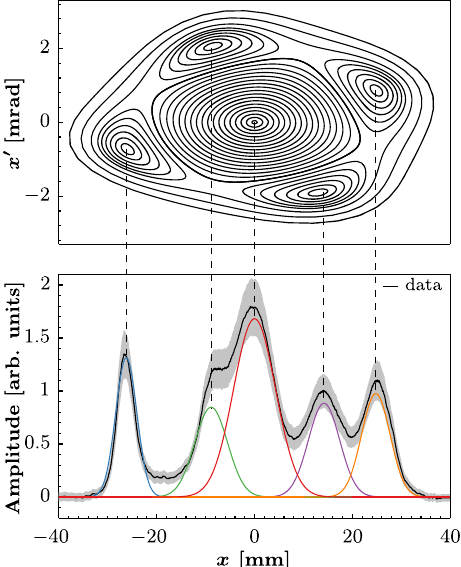
FIG. 9. Simulated horizontal phase space at the location of WS54 (top) and measured profile (bottom), which corresponds to an average value over 100 measurements. The grey band represents the one sigma standard deviation and the colored lines the Gaussian fits for the different beamlets, with the only constraint being the equal integral of the functions corresponding FIG. 8. Reconstructed two-dimensional probability distribution to the four islands. Excellent agreement between the predicted function for η and programmed tune offset with respect to the MTE positions of the SFP and the actual measurement is obtained, nominal settings. A parabolic shape of the level lines of the which is indicated by the dashed probability distribution function is clearly visible.